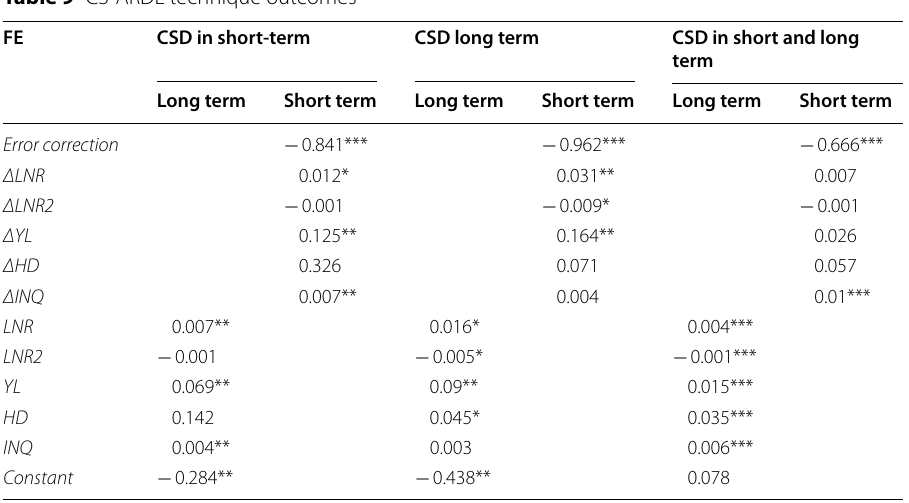
Table 9 CS-ARDL technique